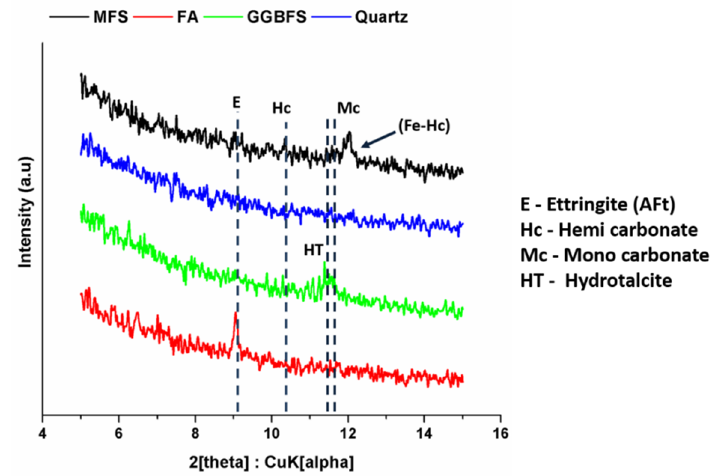
Figure 3. XRD analysis R 3 model paste after 7 days.